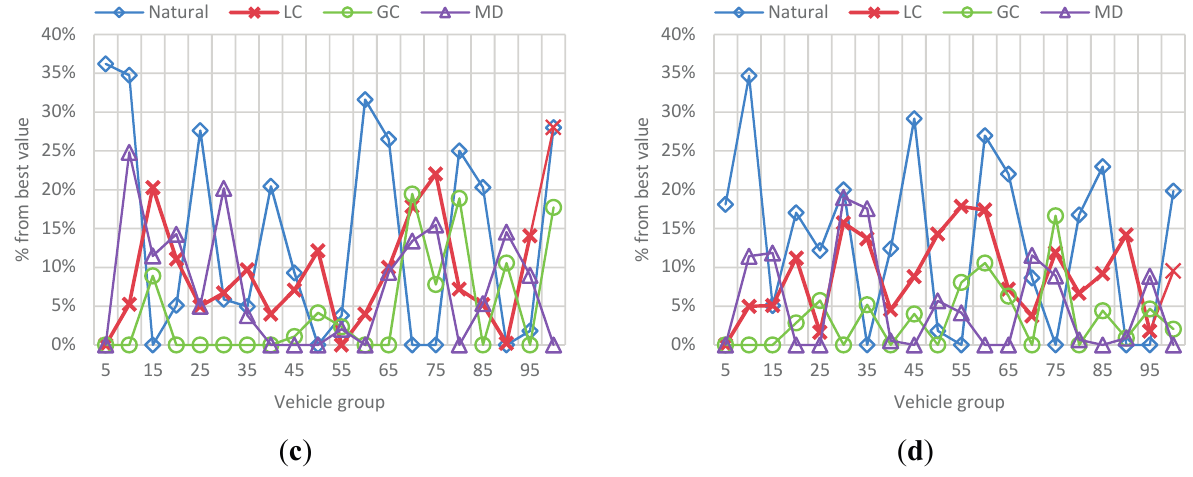
Figure 26. Best value comparison for efficiency in the F-vehicles scenario. ( a ) Percentage comparison against the best value obtained for efficiency for each 5-vehicles set when F is 10; ( b ) Percentage comparison against the best value obtained for efficiency for each 5-vehicles set when F is 20; ( c ) Percentage comparison against the best value obtained for efficiency for each 5-vehicles set when F is 30; ( d ) Percentage comparison against the best value obtained for efficiency for each 5-vehicles set when F is